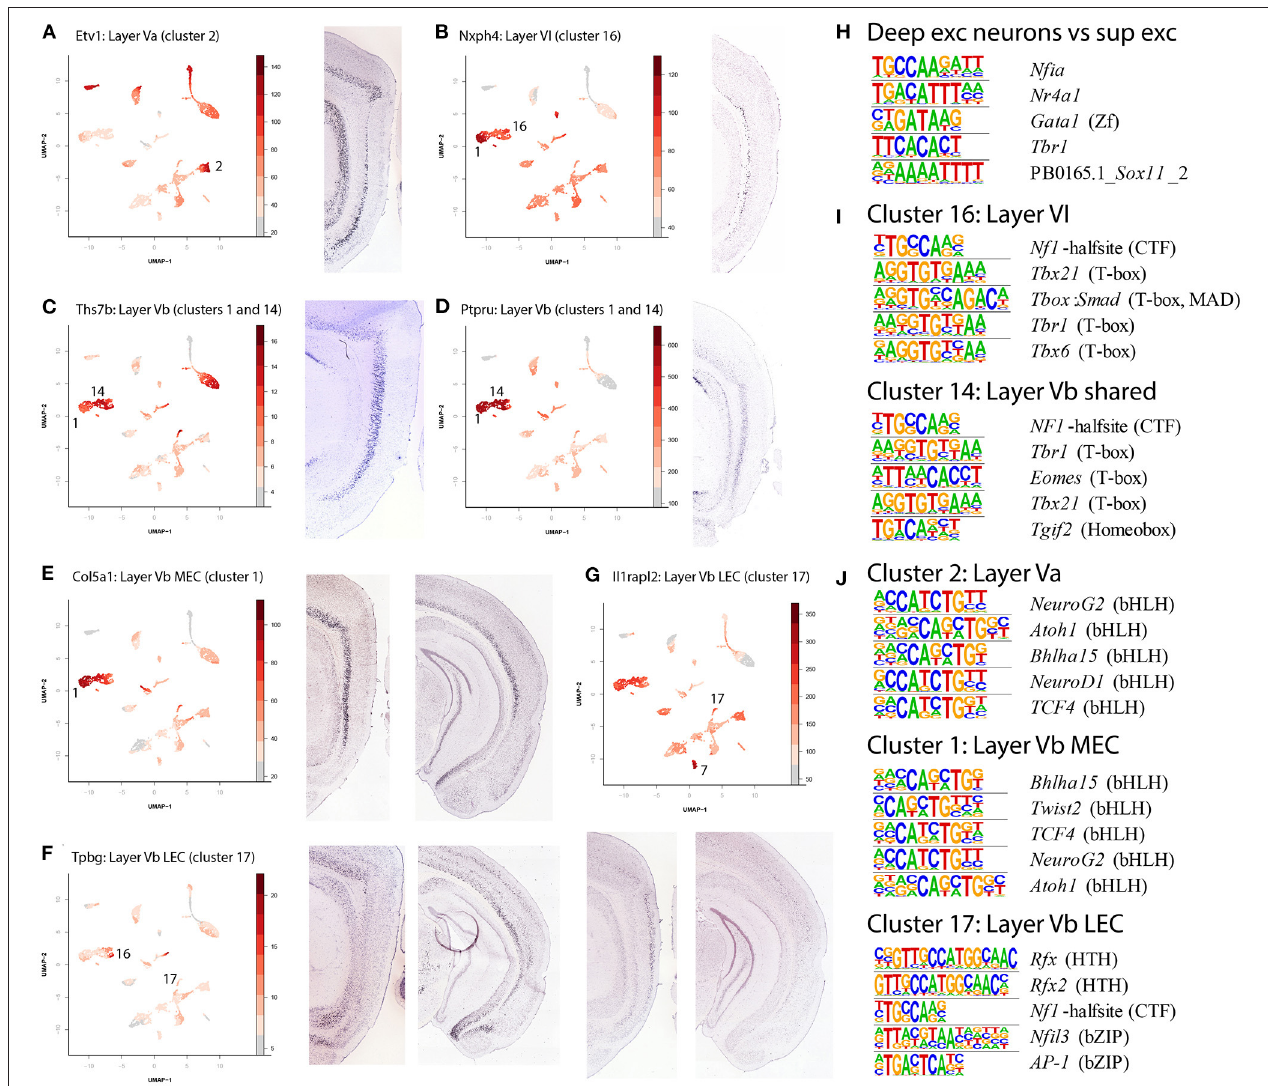
FIGURE 4 | Identification of deep layer excitatory neuron clusters and enriched motifs. (A) Identification of Layer Va (LEC and MEC, cluster 2) cells by accessibility of Etv1 . (B) Identification of Layer VI (LEC and MEC, cluster 16) cells by accessibility of Nxph4 . (C) Identification of Layer Vb (LEC, MEC shared, clusters 1 and 14) cells by accessibility of Ths7b . (D) Identification of Layer Vb (LEC, MEC shared, clusters 1 and 14) cells by accessibility of Ptpru . (E) Identification of Layer Vb (MEC only, cluster 1) cells by accessibility of Col5a1 . (F) Identification of Layer Vb (LEC only, cluster 17) cells by accessibility of Tpbg . (G) Identification of Layer Vb (LEC only, cluster 17) cells by accessibility of Ilrapl2 . (H) Enriched motifs in the deep layers of the EC and their corresponding best matching transcription factor. Here selected DARs of all excitatory deep layer neurons were contrasted with selected DARs of all excitatory superficial layer neurons. (I) Enriched motifs in clusters 14 and 16. Here selected DARs of cluster 16 (LVI) were with all other non-overlapping DARs, and the same was done for cluster 14 (LVb). Note that the Tbr1 motif is the same as the one in (H) , but in reverse complement. (J) Enriched motifs in clusters 1, 2, and 17. The contrasts are similar to the ones in (I) , contrasting selected DARs of one cluster with all other, non-overlapping,